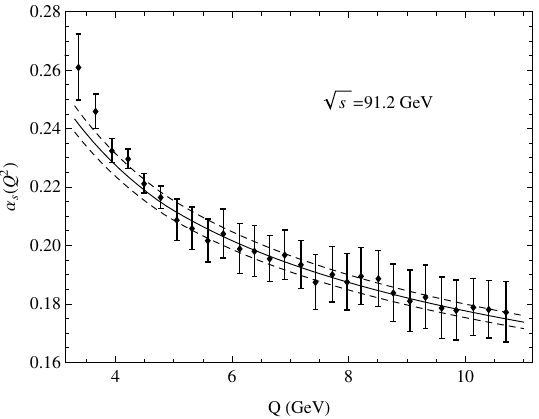
Figure 16. Similar to figure 12, but α s ( Q 2 ) extracted from the C-parameter ( C )